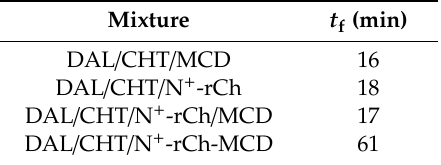
Table 5. Complete hydrolyses times ( t f , min) of DAL (0.68 mM) in fresh mixtures and lyophilized